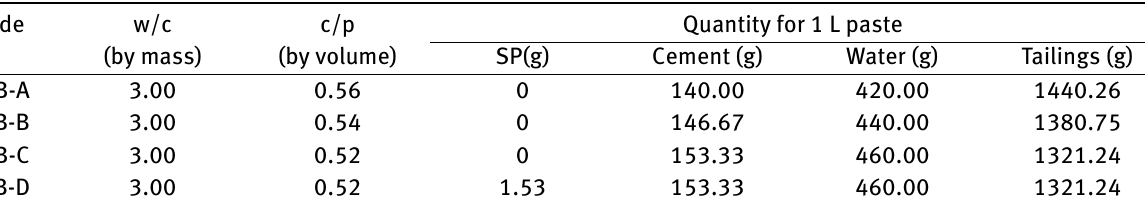
Table 3: Mixture proportions of CPB. w/c refers to the water-to-cement ratio, whereas c/p refers to solid content volume and is the volume of cement and tailings per volume CPB.